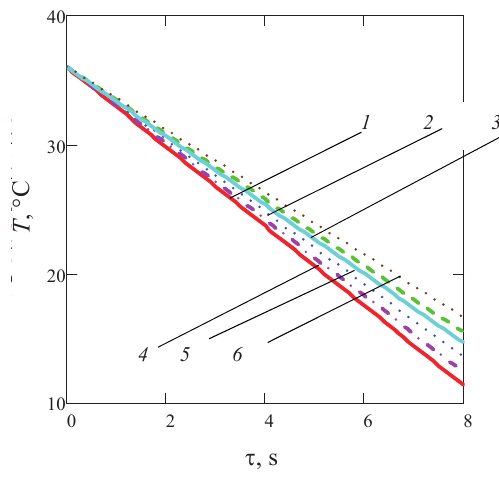
Figure 7 Dependency temperature Т cooled fluid from a feed from time τ with different values of m porosity, coefficient α transfer heat, criterion Bi, diameter d ball ( z = 0,5 m; m = 0,5; Т 0 = 36 С ; = 440 W/(m 2 К ); Bi = 15: 1 – d = 0,0375 m, 2 – d = 0,04 m, 3 – d = 0,0425 m; m = 0,35; Т 0 = 36 С ; = 440 W/(m 2 К ); Bi = 10: 4 – d = 0,0375 m, 5 – d = 0,04 m, 6 – d = 0,0425